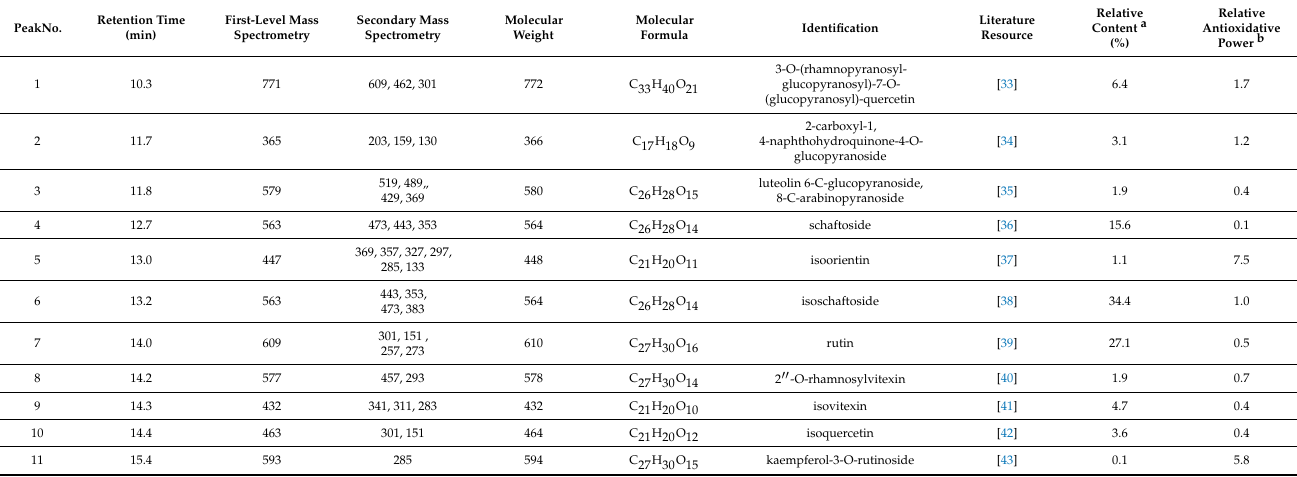
Table 1. Flavonoids identified in the fig leaves extracts using HPLC-QTOF-MS/MS.